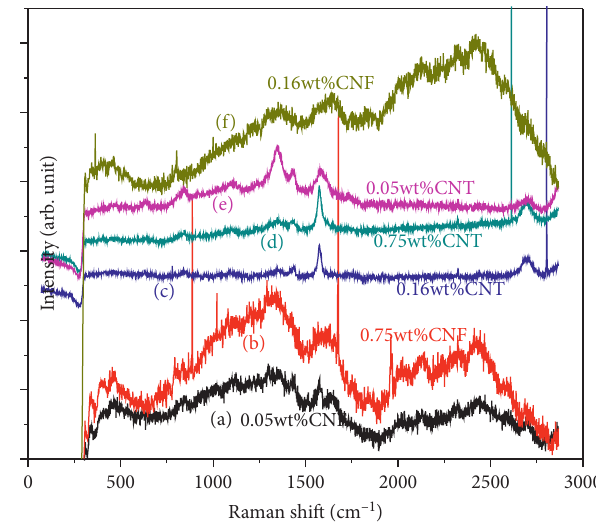
Figure 4: Raman spectra of PVDF/CNF and PVDF/CNT with various